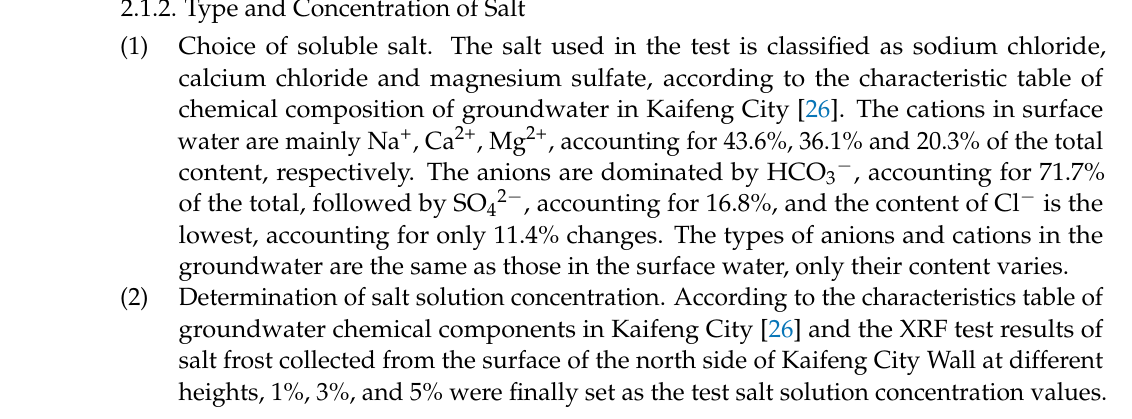
Figure 2. Microscopic SEM image of untested gray brick sample.